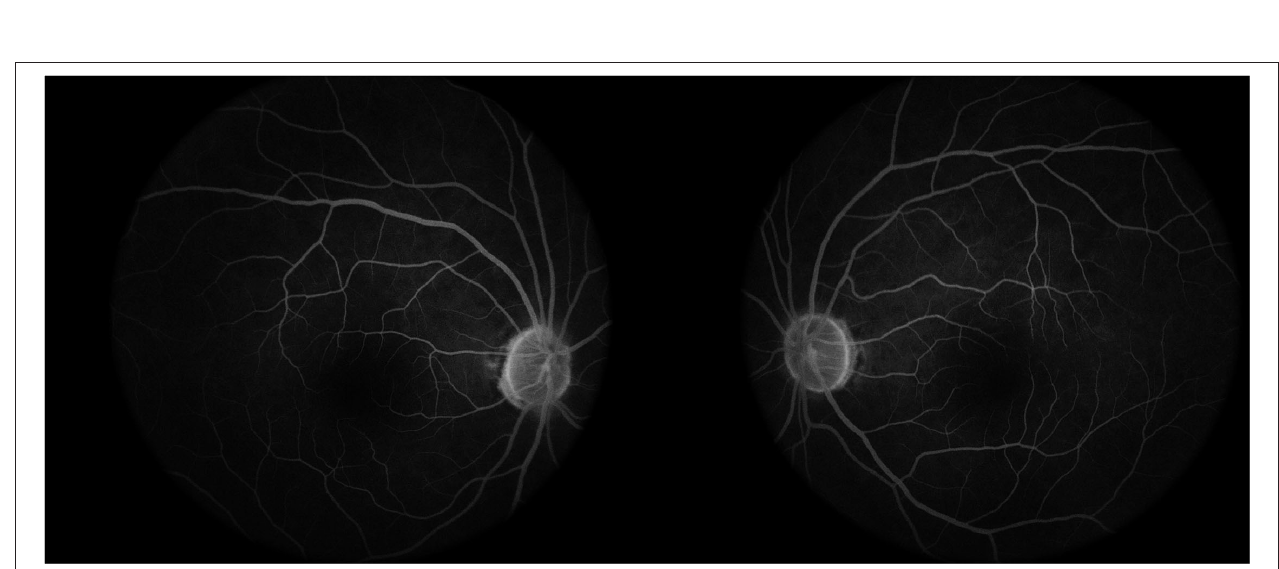
FIGURE 2 | The fundus fluorescein angiography (FFA) examination of a prediabetes patient shows no obvious abnormality.